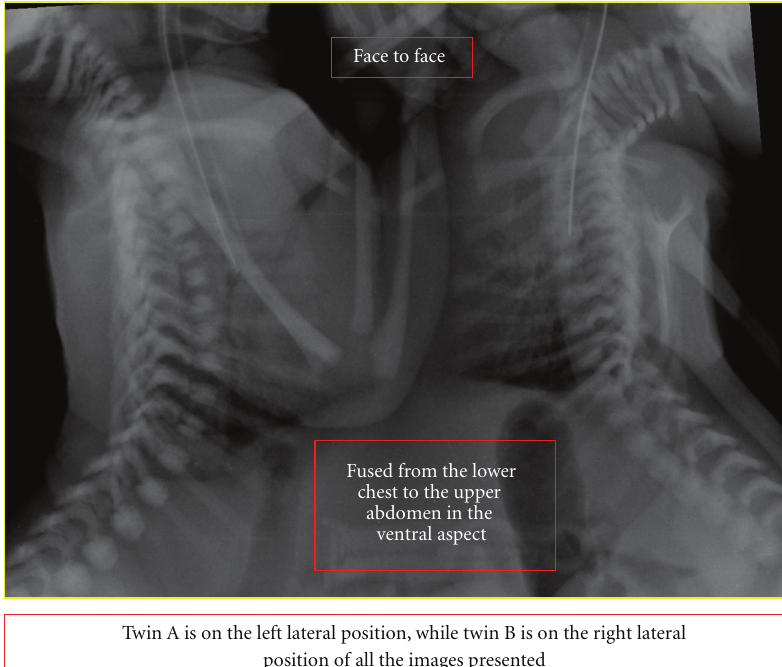
Figure 1: Twin A is on the left lateral position, while twin B is on the right lateral